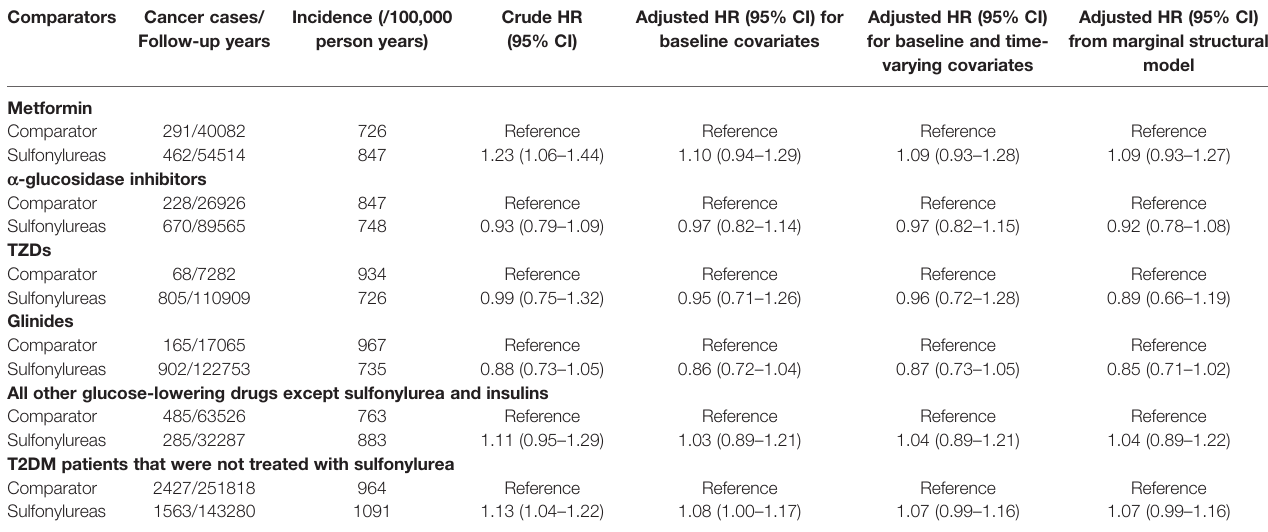
TABLE 2 | Association between the sulfonylurea use and risk of all cancers. Comparators Cancer cases/ Incidence (/100,000 Follow-up years person years)